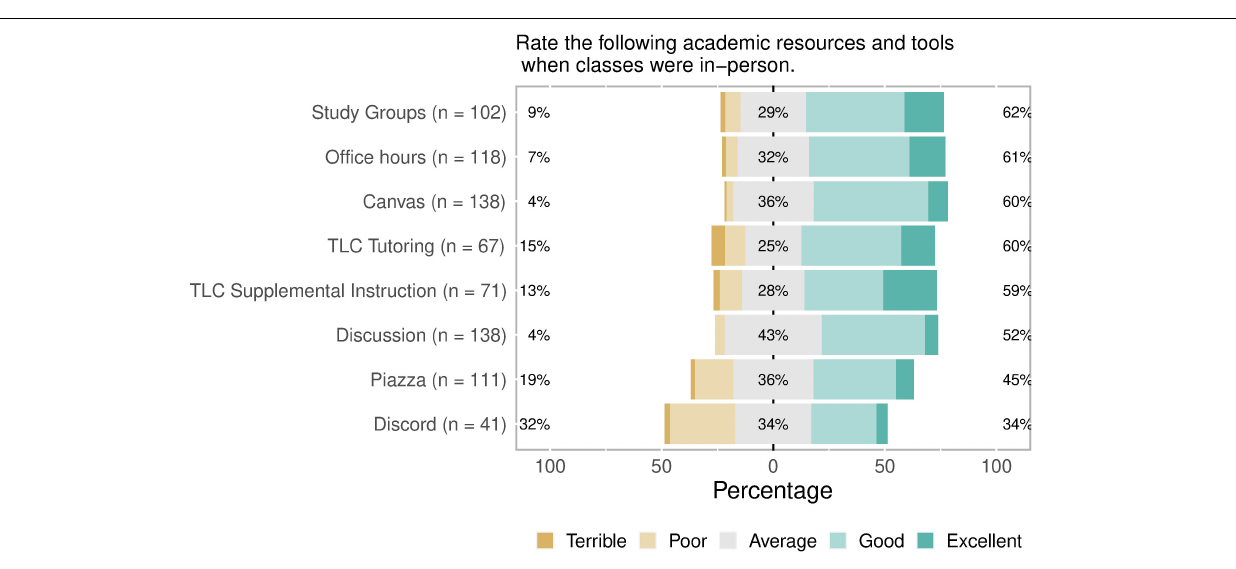
FIGURE 5 | Students’ reported approval ratings of certain academic resources and tools when classes were